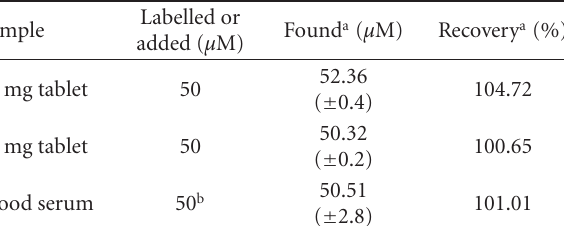
Table 1: Determination of captopril in formulations and blood serum